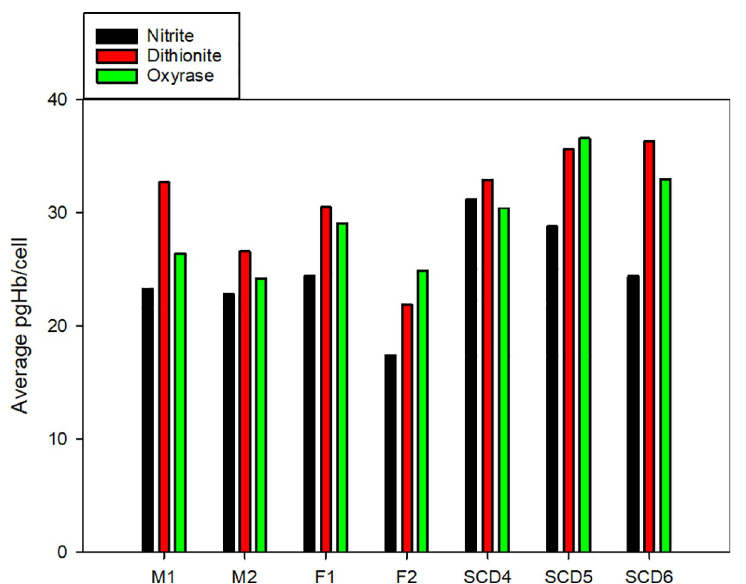
Fig 6. Average pgHb per cell for all donors. CTV data for all donors and conditions in Fig 5 are summarized in a bar graph.